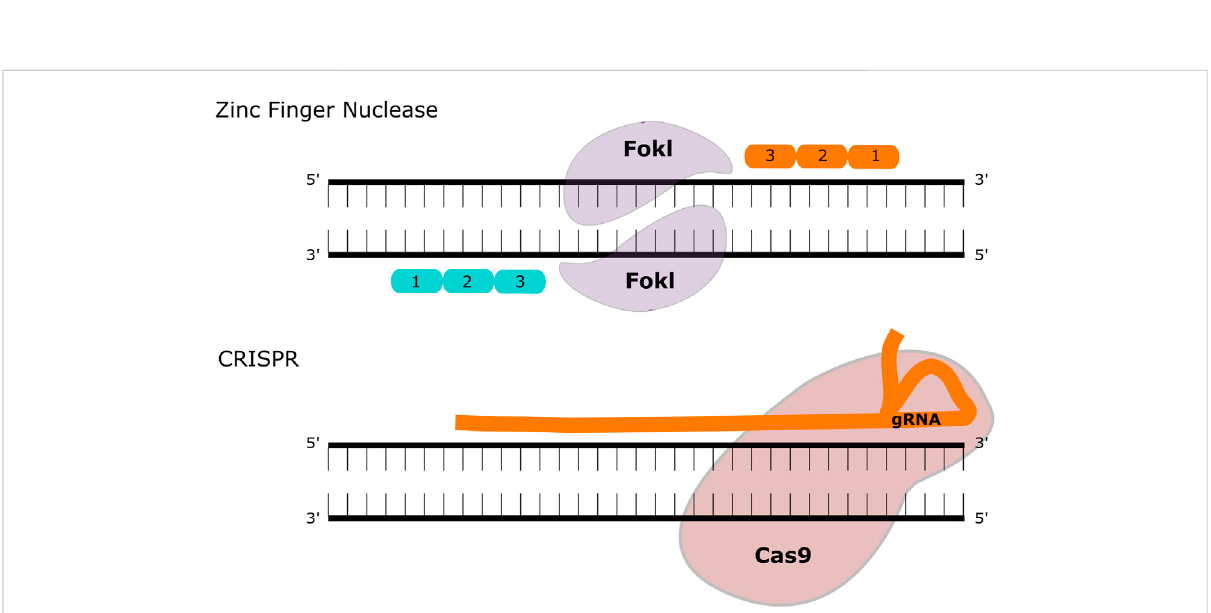
FIGURE 2 Gene Editing Methodologies for MPS. ZFNs contain two functional domains, a DNA binding and a DNA cleaving domain (comprised of the FokI nuclease). These create double-strand breaks that can be repaired with homologous recombination or non-homologous end joining. The